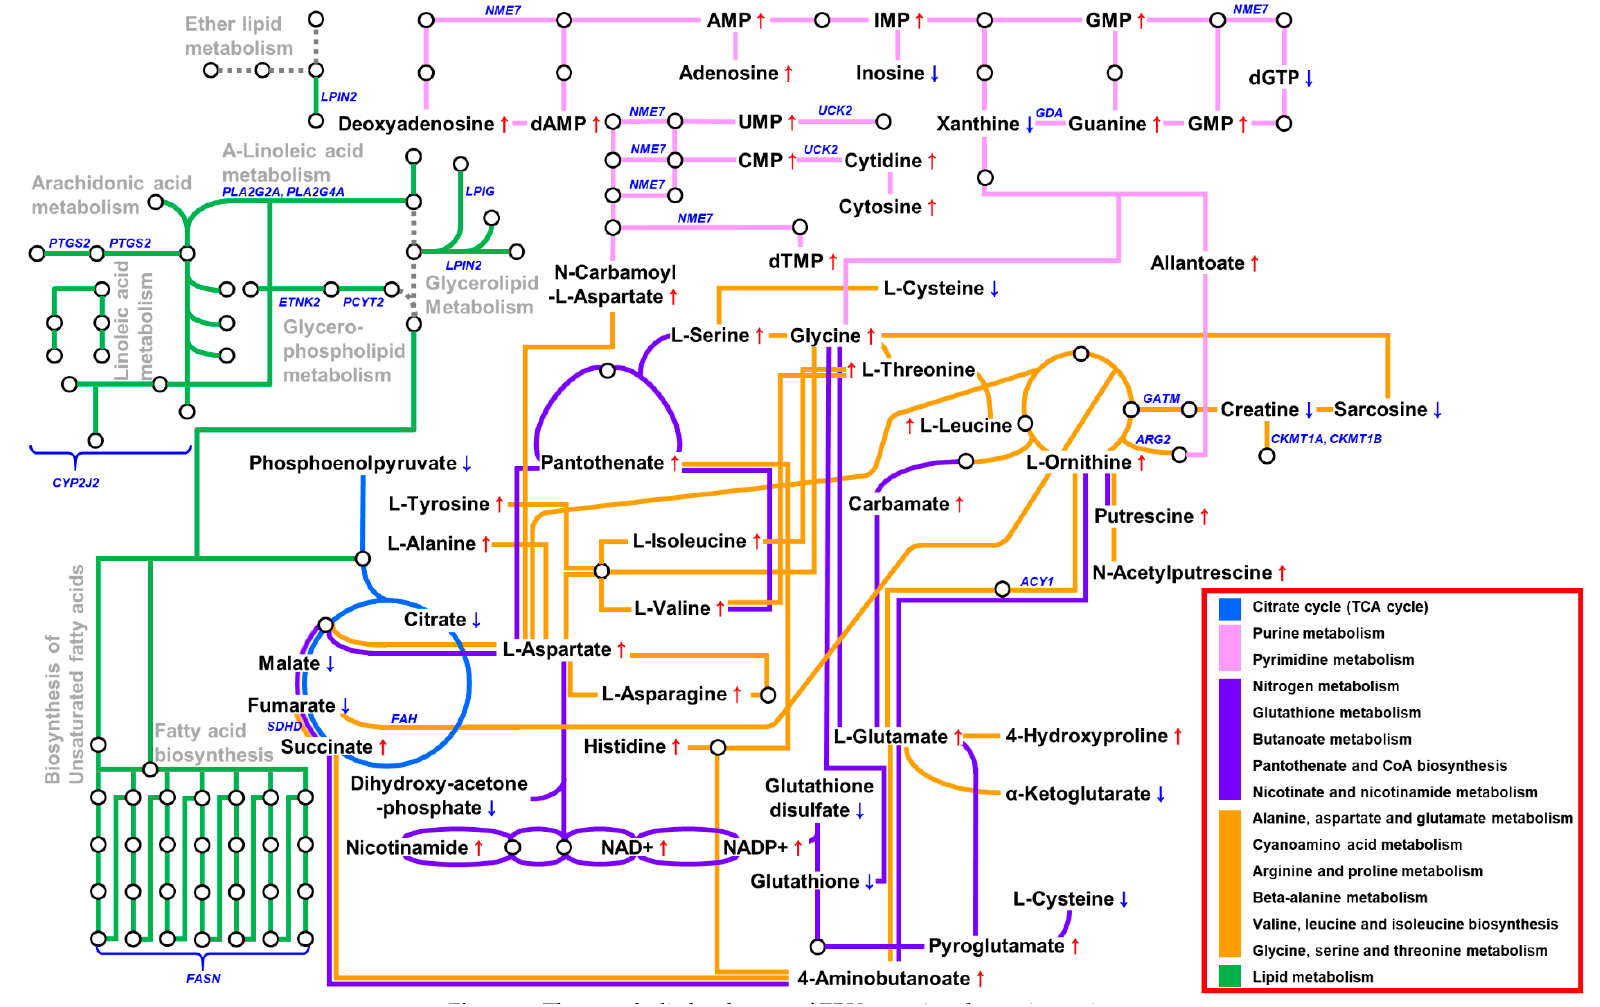
Figure 5 . The metabolic landscape of EBV-associated gastric carcinoma. Figure 5. The metabolic landscape of EBV-associated gastric